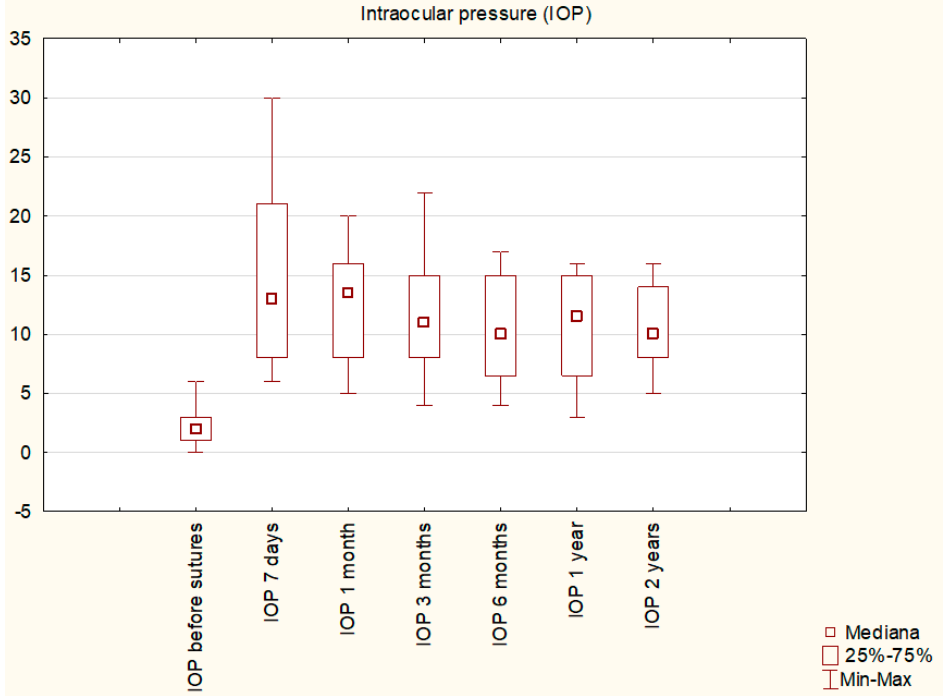
Figure 1. Changes in the intraocular pressure during the study